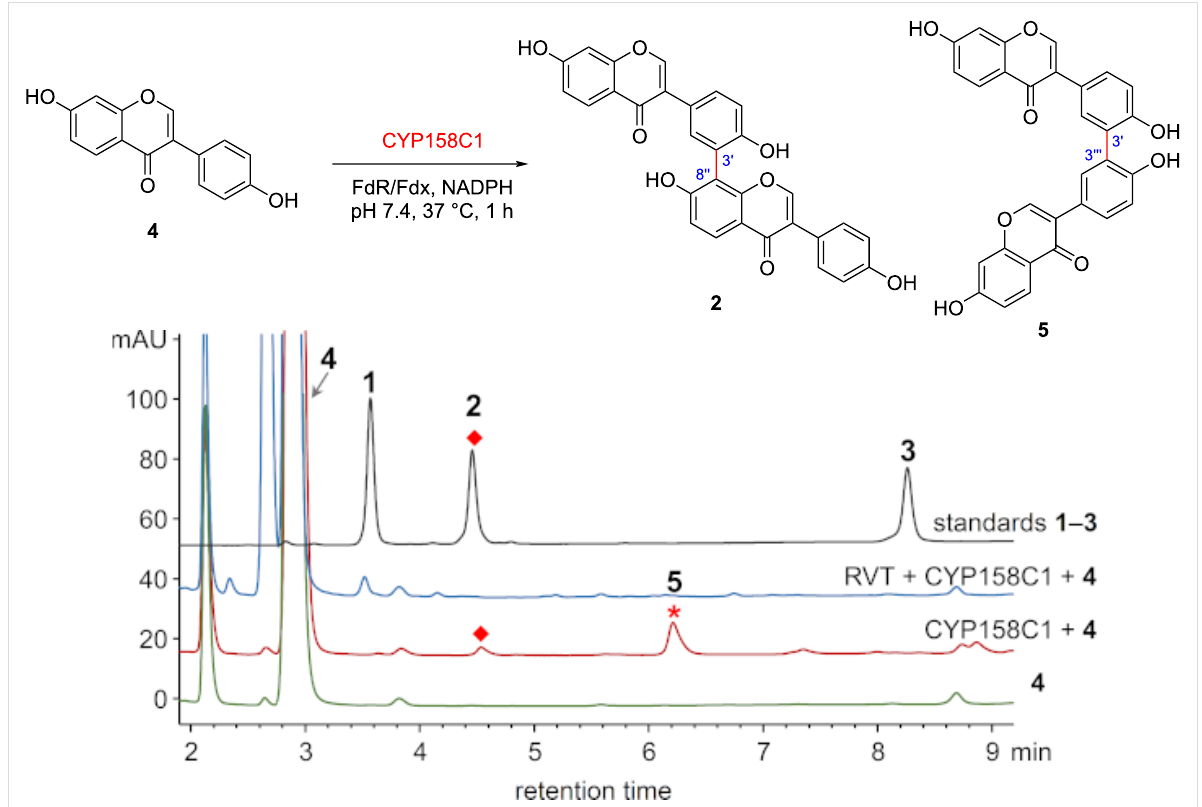
Figure 3: CYP158C1 dimerizes 4 to form dimers 2 and 5 in vitro (analytical method B, 254 nm). Control conditions (green): 4 (0.4 mM), NADPH (1 mM), and ferredoxin–NADP + reductase Sel FdR0978/ferredoxin Sel Fdx1499 (FdR/Fdx, 5 µM) in buffer (50 mM PBS, 0.2 mM DTT, 1 mM EDTA, pH 7.4) were incubated at 37 °C for 1 h. Red: the conditions above with the addition of CYP158C1 (3 µM). Blue: the conditions above with the addition of CYP158C1 (3 µM) and RVT (0.5